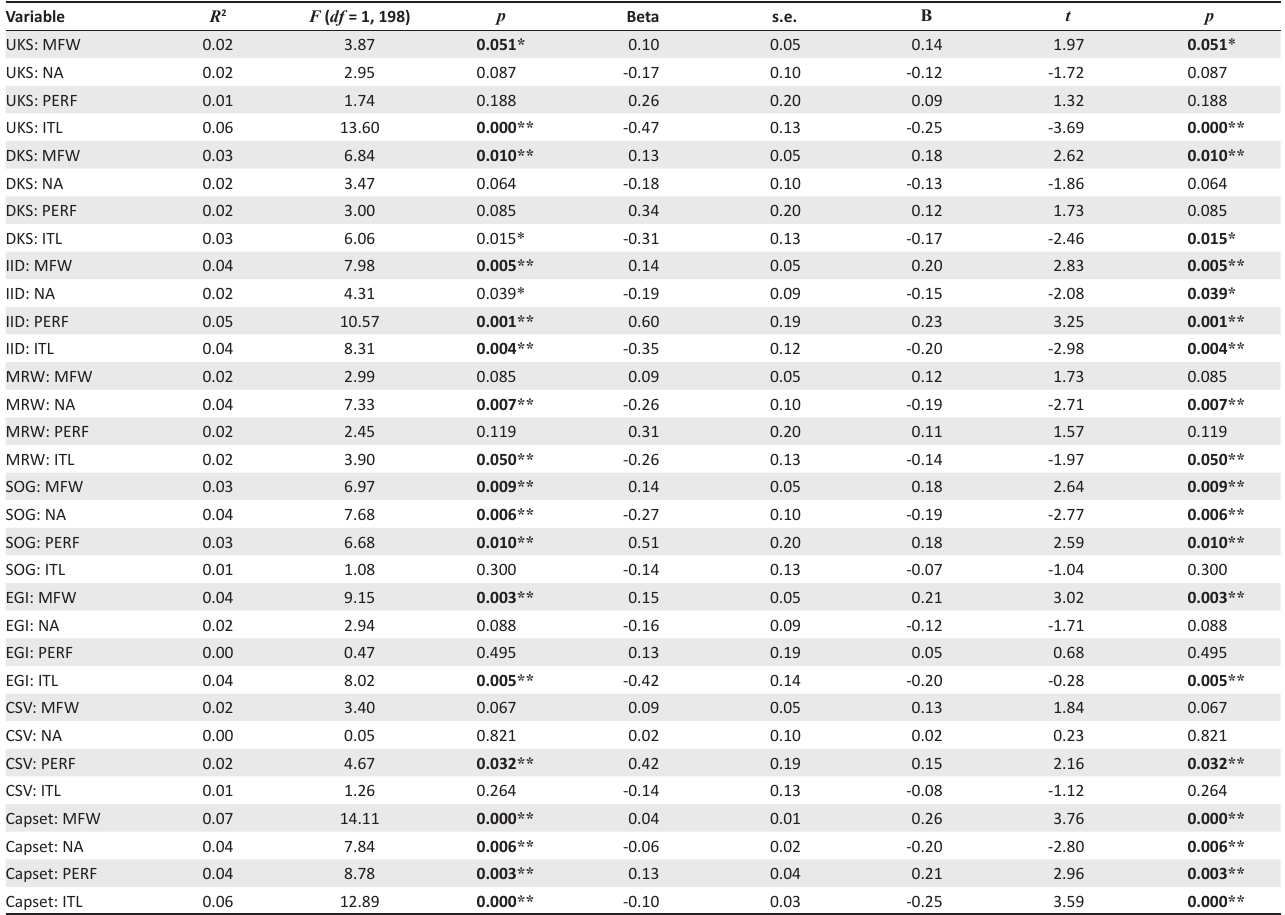
TABLE 4: Multiple regression of capabilities and the capability set on functionings.